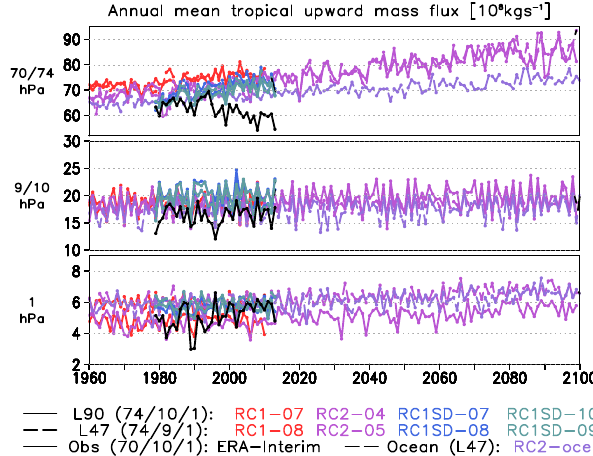
Figure 24. Mean age of stratospheric air (years) at 47hPa / 48hPa / 20km, 90 ◦ N–90 ◦ S, averaged for the years 2002 to 2011. The simulation results (colours) are compared to MIPAS data